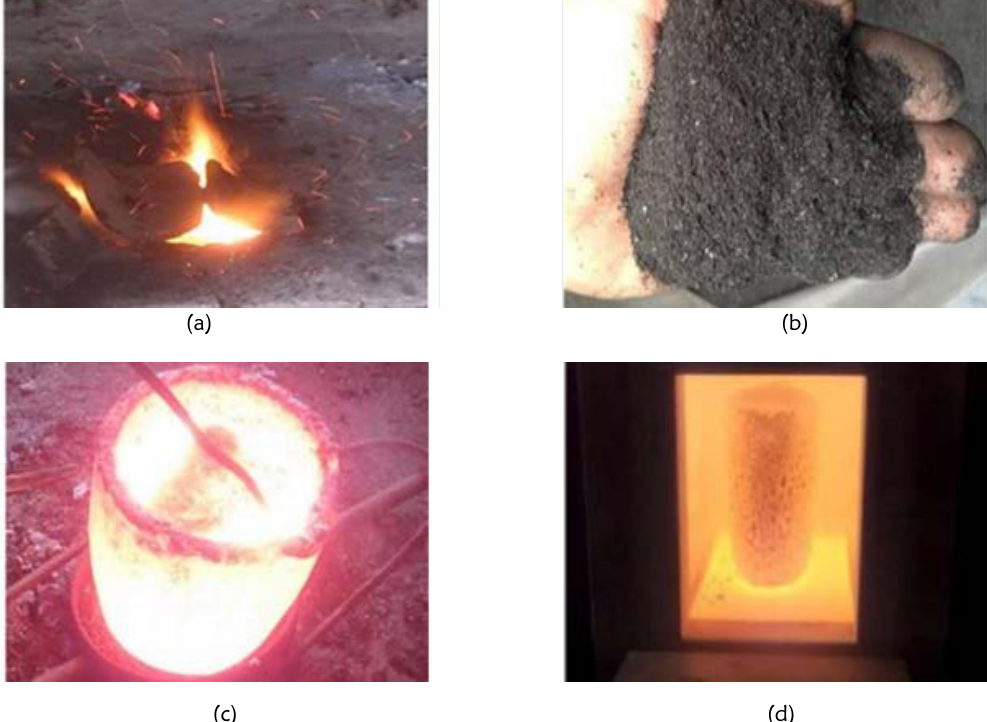
Figure 4: Preparation of rice husk ash (a) rice husk burning in furnace, (b) rice husk ash, (c) rice husk is being moved to electric furnace and (d) heated in electric